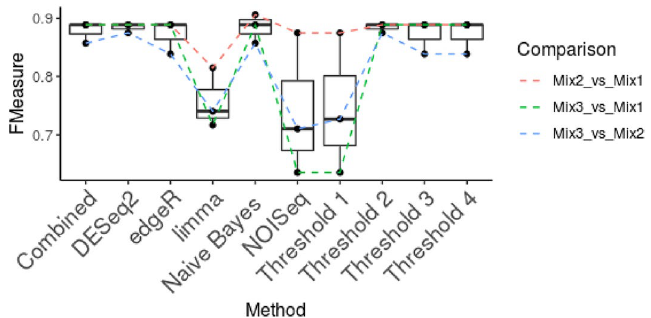
Figure 4. Performance of the different DEG detection methods and vote system to detect DEGs. Boxplots showing the distributions of F-measure values for each method and combination approach. Individual data points are shown and connected according to the comparison between spike-ins for which they were calculated. Combined refers to the combined-FDR results. Threshold refers to the minimum-vote threshold for combining method results.